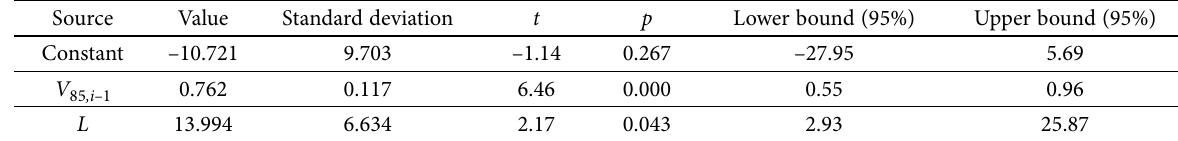
Table 6. Model parameter estimates ( V 85 ,t